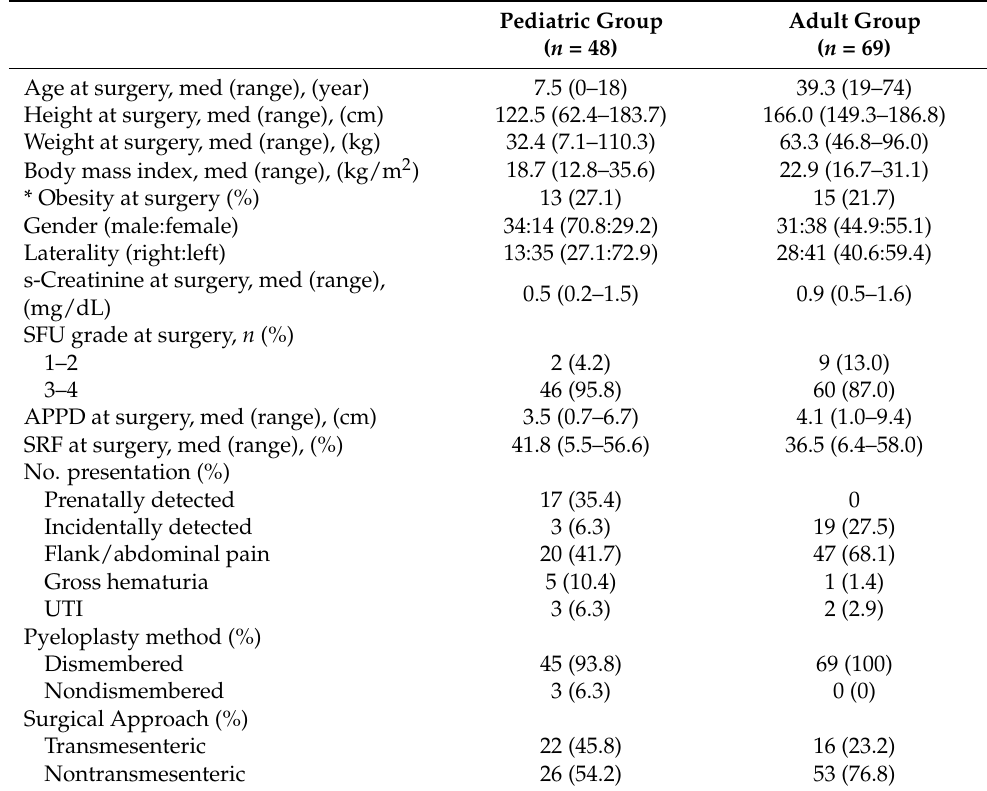
Table 1. Patient demographics according to age groups.